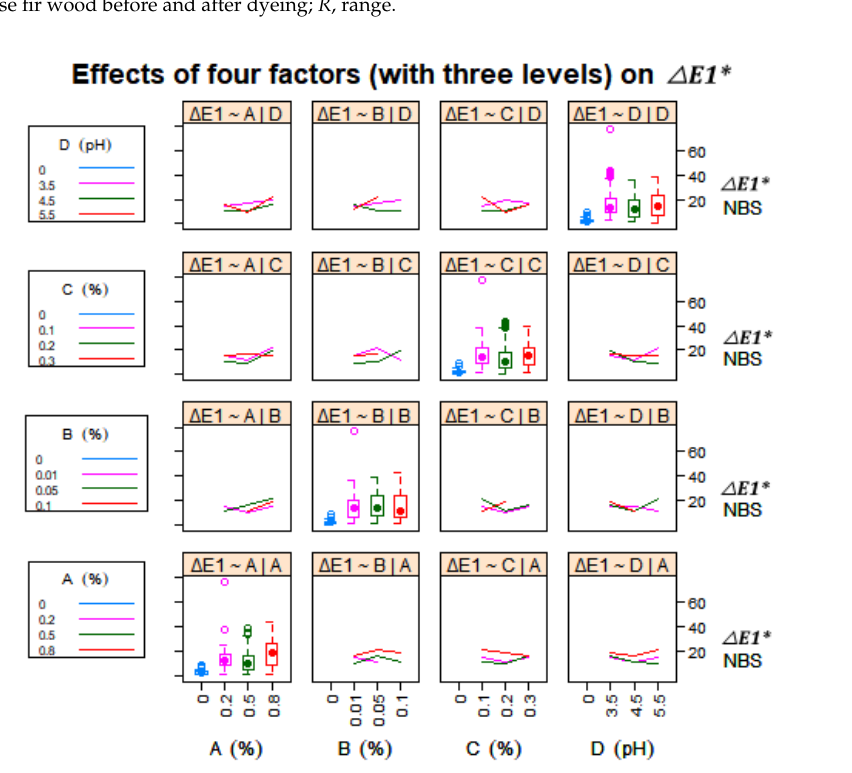
Figure 2. Effects of four factors (all with three levels) on ∆ E 1 * . ∆ E 1 * is the total color difference (NBS). NBS is the unit of color difference, established by the National Bureau of Standards. When the color difference ∆ E 1 * = 1, it is called one NBS unit. A is reactive dye (%) with three levels of 0.2% ( A 1 ), 0.5% ( A 2 ), and 0.8% ( A 3 ). B is penetrant (%) with three levels of 0.01% ( B 1 ), 0.05% ( B 2 ), and 0.10% ( B 3 ). C is KH 2 PO 4 (%) with three levels of 0.1% ( C 1 ), 0.2% ( C 2 ), and 0.3% ( C 3 ). D is pH with three levels of 3.5